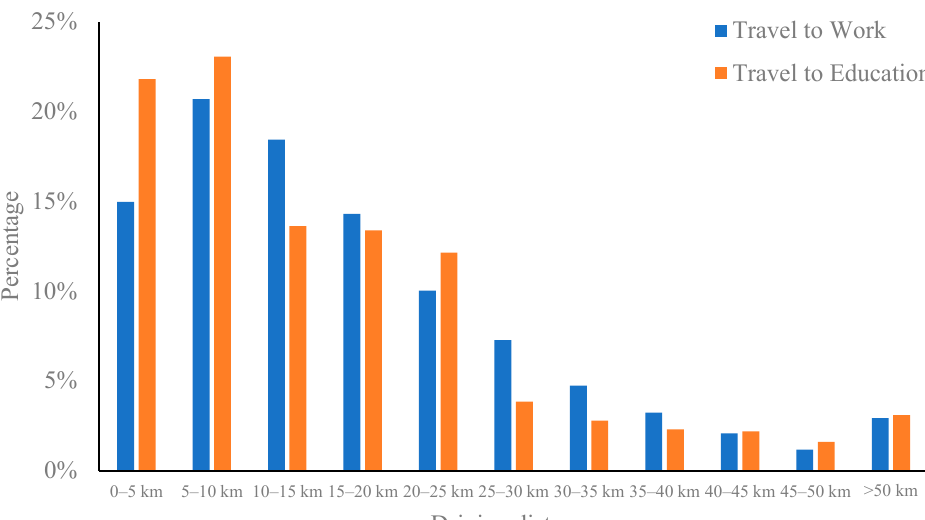
Figure 1. Distribution of car travel distance to work and education (weekday).